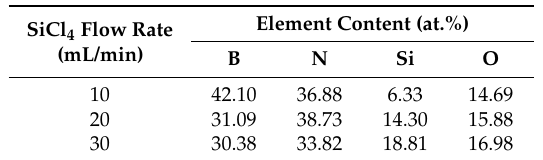
Table 2. Element content of SiBN ceramic deposited at various SiCl 4 flow rates analyzed by X-ray photoelectron spectroscopy